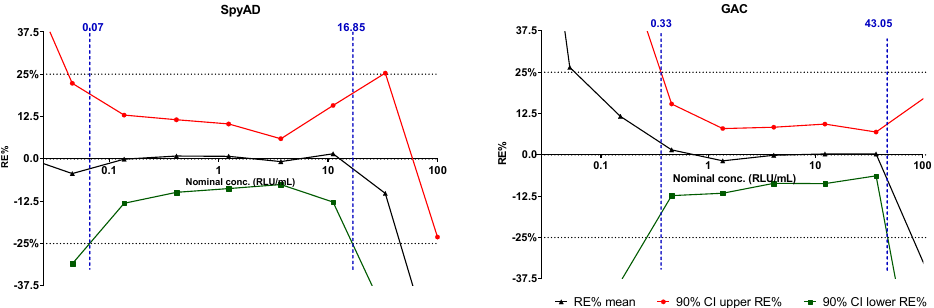
Figure A3. Accuracy assessment. % relative error (black line) with 90% upper(red) and lower (green line) confidence intervals, against nominal concentration of standard curve from 12 independently performed assays. From the plotted values the upper and lower limits of standard curve accuracy could be interpolated from with a conservative threshold where there is a 90% probability that the relative error is <25%.